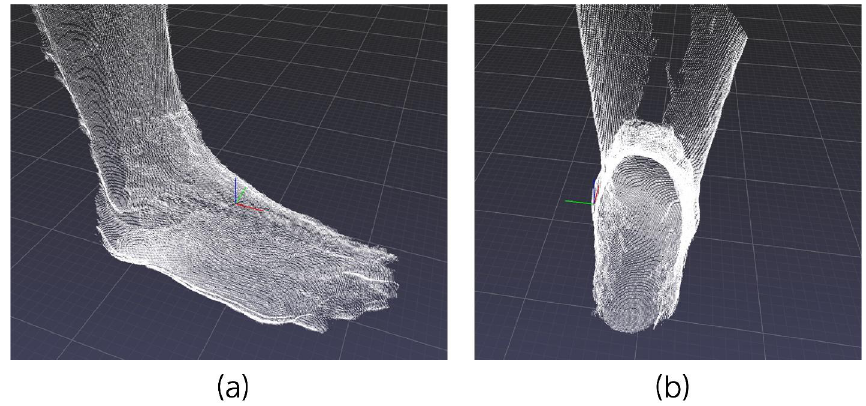
Fig. 9 Reconstruction result, (a) side view, (b) back